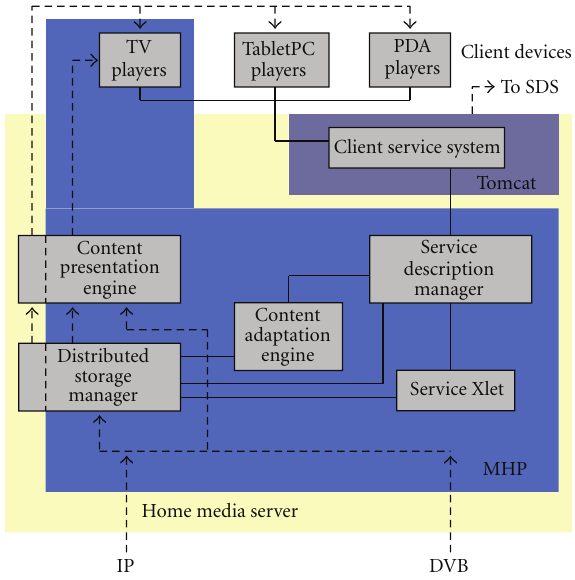
Figure 2: System architecture of content access